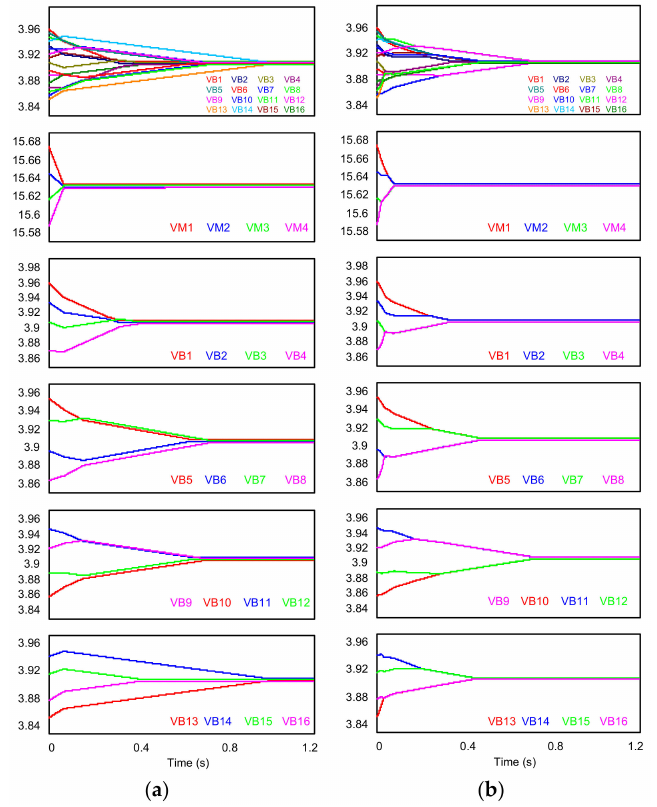
Figure 8. 16 cells voltage trajectories in simulation ( a ) PAE ( b )